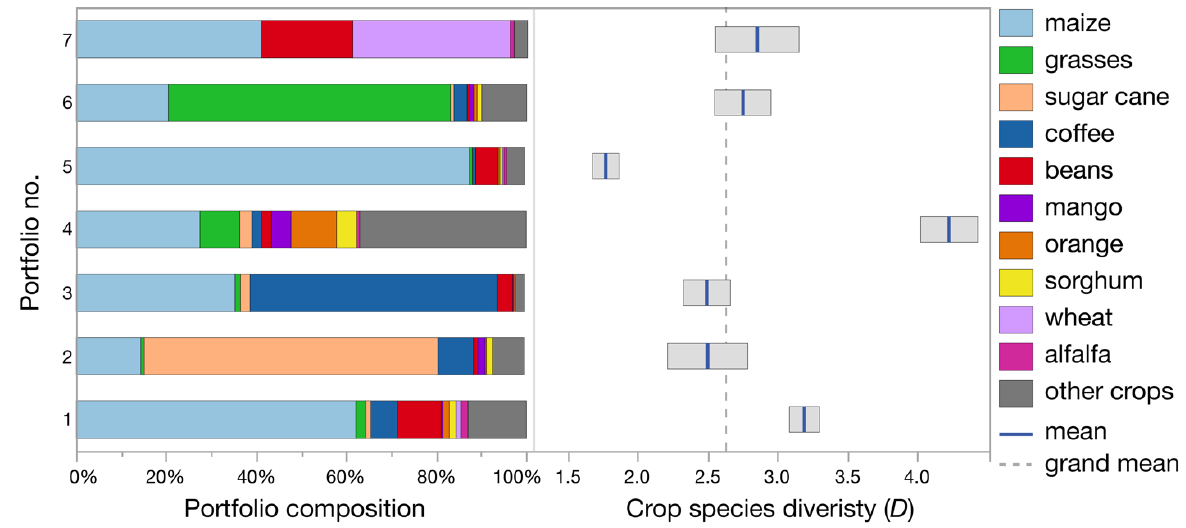
Figure 5. Crop composition and species diversity in the municipalities in each of the seven crop portfolios. Portfolio composition is shown as the mean shares of cropland areas occupied by the 10 dominant crops in the study region (i.e., crops occupying the largest shares of total cropland area). Cropland area shares of the remaining 294 crops are represented as ‘other crops’ (dark gray bars). Mean crop species diversity (Shannon effective diversity) in municipalities in each portfolio is shown with vertical blue lines surrounded by each’s 95 percent means confidence intervals (light gray bars). The grand mean crop species diversity is shown with the gray dashed line ( D = 2.6).